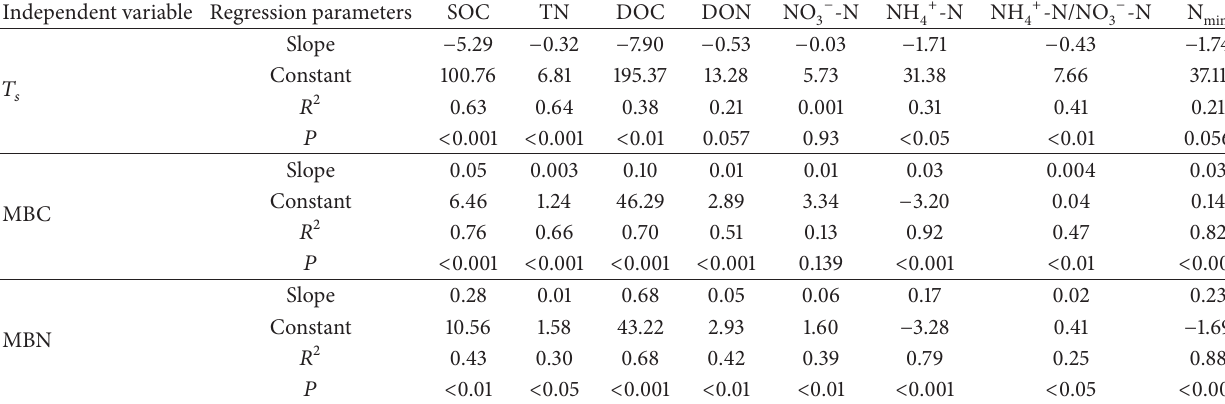
Table 2: Single factor linear regressions between soil properties (soil organic C, SOC; total N, TN; dissolved organic C, DOC; dissolved organic N, DON; nitrate N, NO and soil temperature ( 𝑇 𝑠 ), soil microbial biomass C (MBC), and N (MBN) showing regression parameters (slope, constant, 𝑅 2 , and 𝑃 ). MBC and MBN data were obtained from Fu et al. [20]. Independent variable Regression